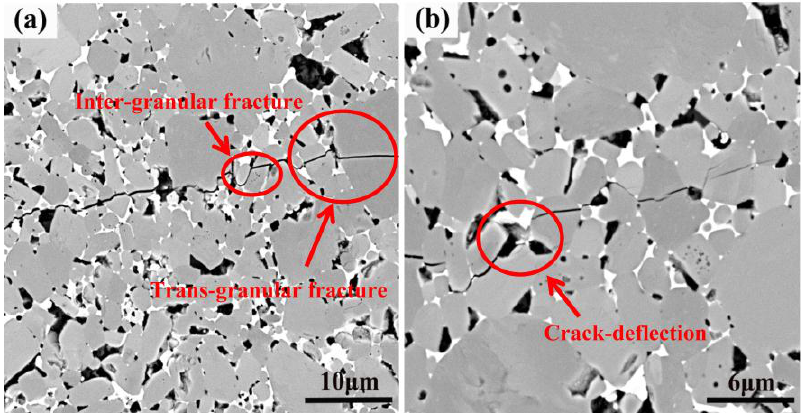
Figure 11. Crack propagation path in the TiB 2 –5 wt% (Fe–Ni–Ti–Al) specimen sintered at 1400 °C for a holding time of 5